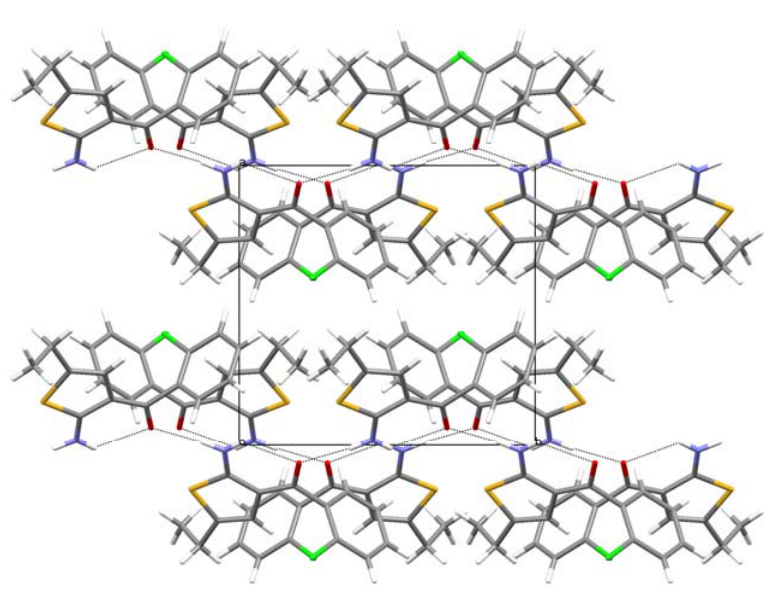
Figure 5. The crystal packing of 2 as seen along direction [12]. N–H···O hydrogen bonds and C–H···Cl contacts are shown as dashed